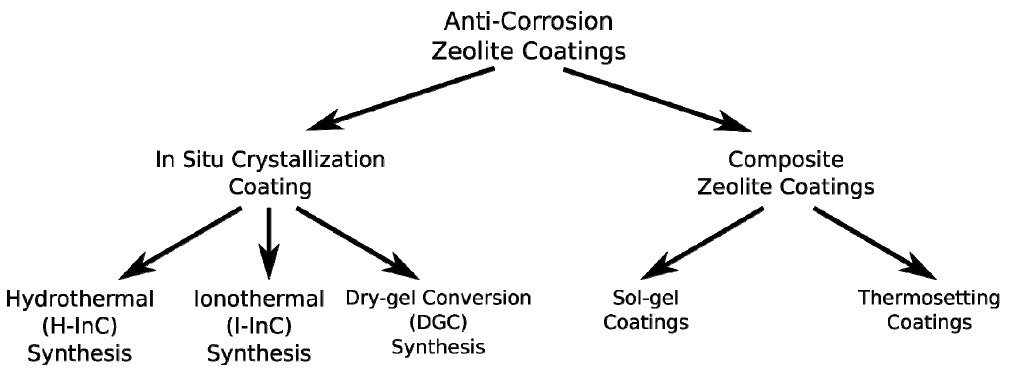
Figure 1. Synthetic scheme of the anti-corrosion zeolite coating techniques.